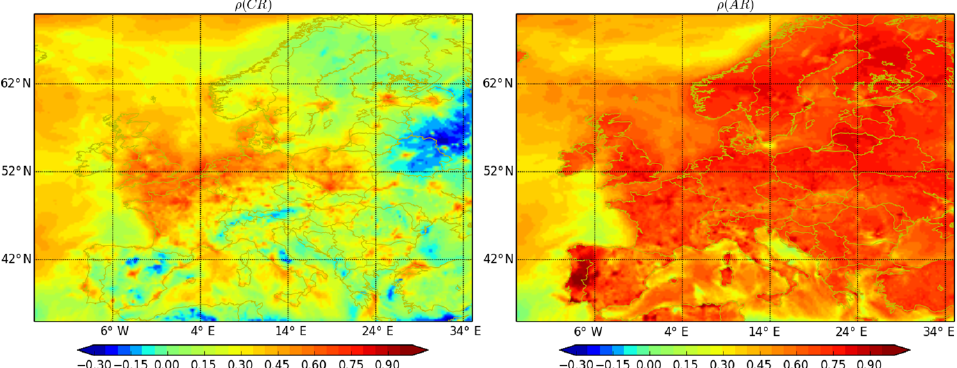
Figure 12. Correlation coefficient between the CR and the NR (left panel) and the AR and the NR (right panel) at the surface and for the northern summer period (1 June–31 August). The labels are longitude in degrees ( x axis) and latitude in degrees ( y axis). Red/blue colors indicate positive/negative values of the correlation